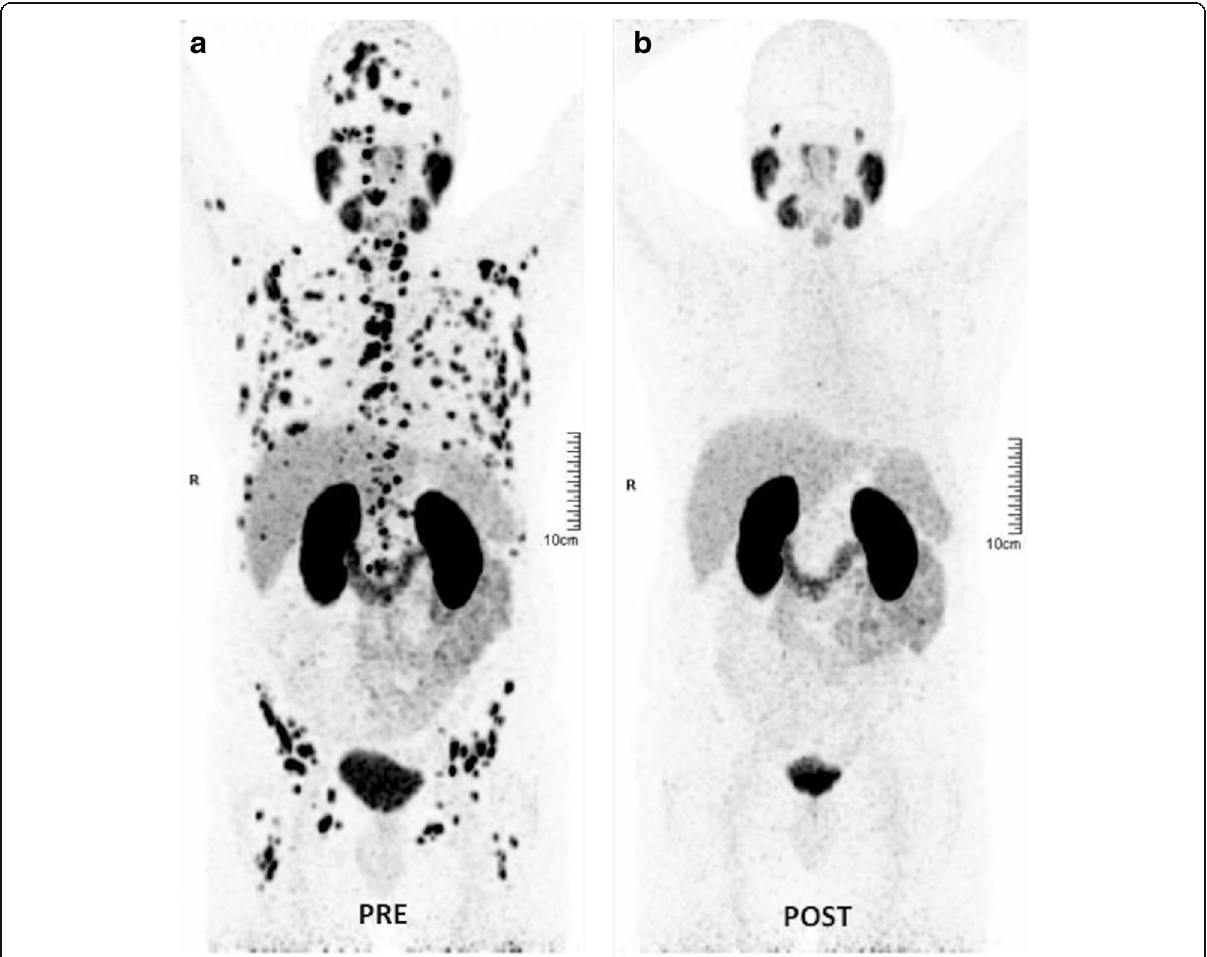
Fig. 11 Theranostic in oncology with PSMA. 177 Lu-PSMA radioligand therapy in a 67-year-old man with metastatic castration-resistant prostate cancer. a Pretherapy. PET image evidenced a difuse metastatic involvement. PSA value 50 ng/ml. b 4 months following the treatment with 177 Lu-PSMA radioligand therapy (8000 MBq), PET showed a complete metabolic response. PSA value 0